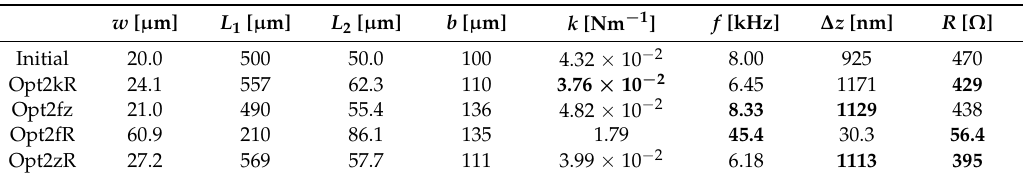
Table 3. Bi-objective optimization results.